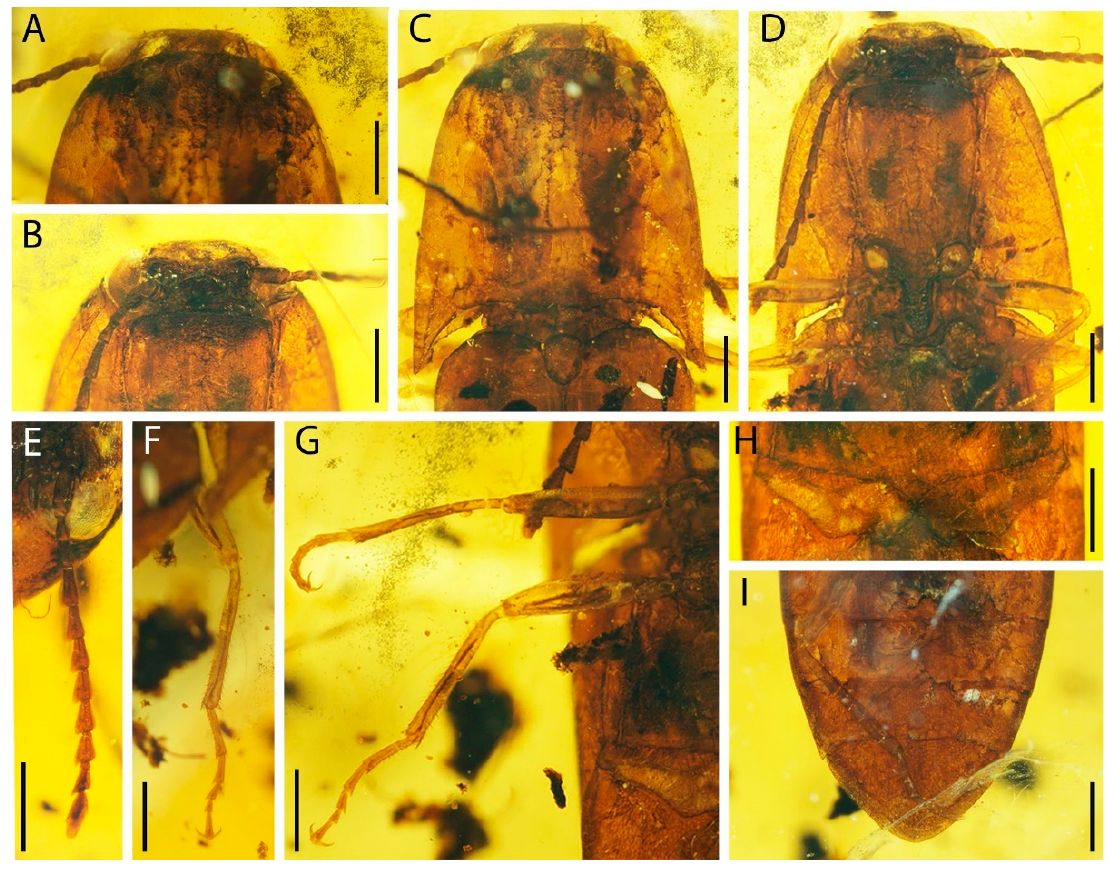
Figure 2. Morphology of Burmogonus cretaceus gen. et sp. nov. ( A ) Head and anterior part of prothorax, dorsal view; ( B ) head and anterior part of prothorax, ventral view; ( C ) head, pronotum, scutellar shield, and base of elytra, dorsal view; ( D ) head, prothorax, and mesothorax, ventral view; ( E ) left antenna, ventral view; ( F ) right mesoleg, dorsal view; ( G ) right pro- and mesoleg, ventral view; ( H ) metacoxal plates, ventral view; ( I ) last four abdominal ventrites, ventral view. Scale bars: 0.5 mm.